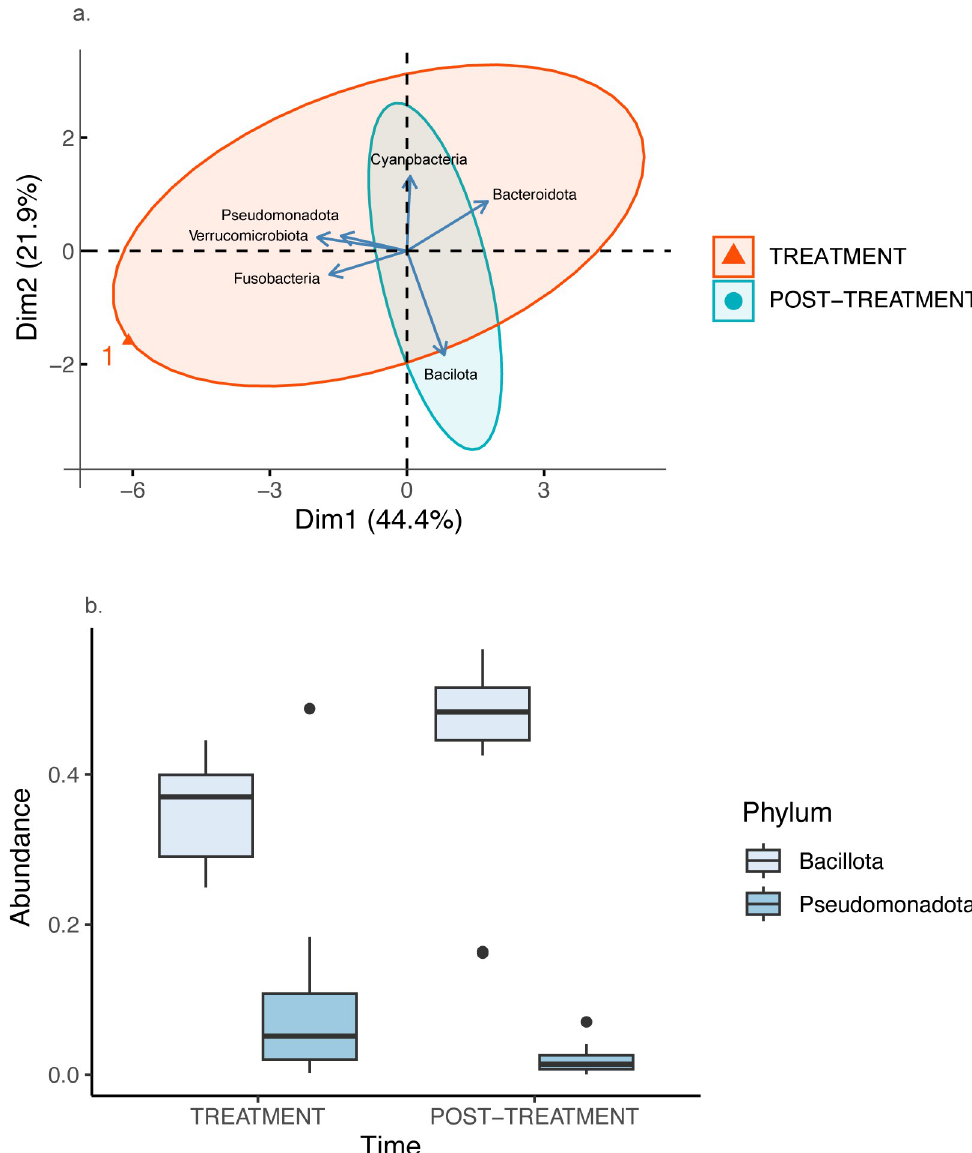
Fig 2. (a) Principal components analysis and (b) Box and whisker plot of two Bacterial Phyla in fawn-footed mosaic-tailed rat ( Melomys cervinipes ) faecal samples. Principal components analysis shows the first two principal components of 6 bacterial phyla for rats treated with antibiotics (red) and more than one year later (blue). Box and whisker plot of Phyla Bacillota (%) and Peusodomonadota (%) for both